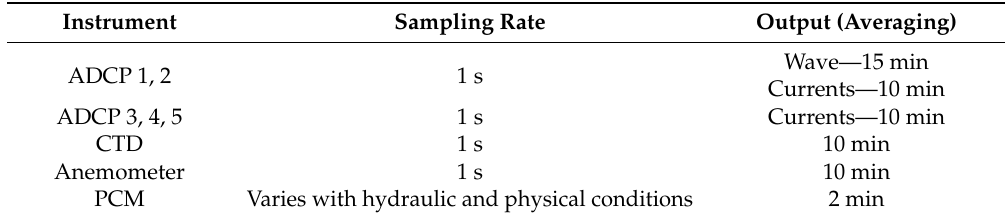
Table 1. Sampling resolution of the instruments deployed at the marina Opatija.